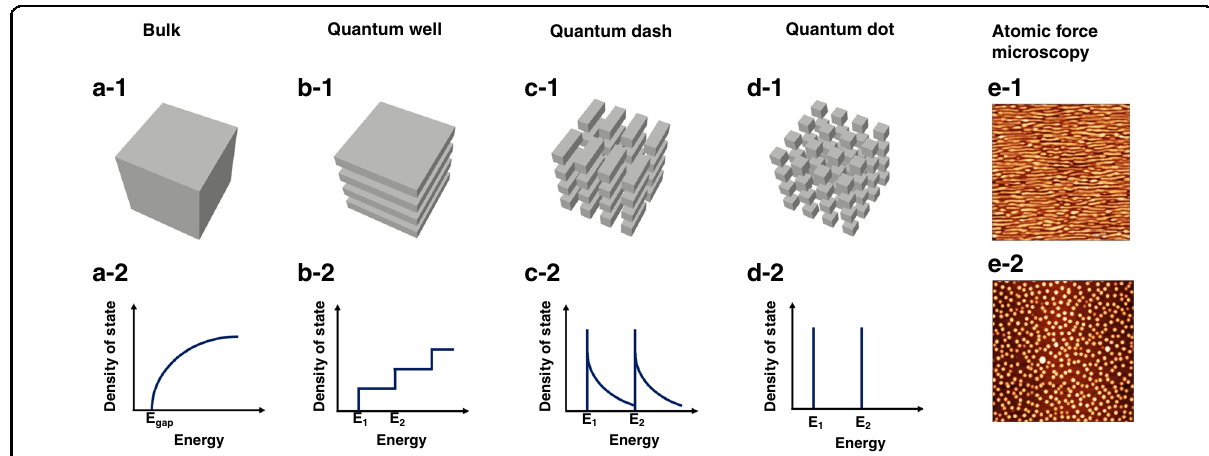
Fig. 1 Structure and evolution of the density of states (DOS) for semiconductor structures with different degrees of dimensionality. ( a-1 , a-2 ) bulk, ( b-1 , b-2 ) quantum well (QW), ( c-1 , c-2 ) quantum dash (QDash), and ( d-1 , d-2 ) quantum dot (QD). Atomic force microscopy image of ( e-1 ) QDash and ( e-2 ) QD